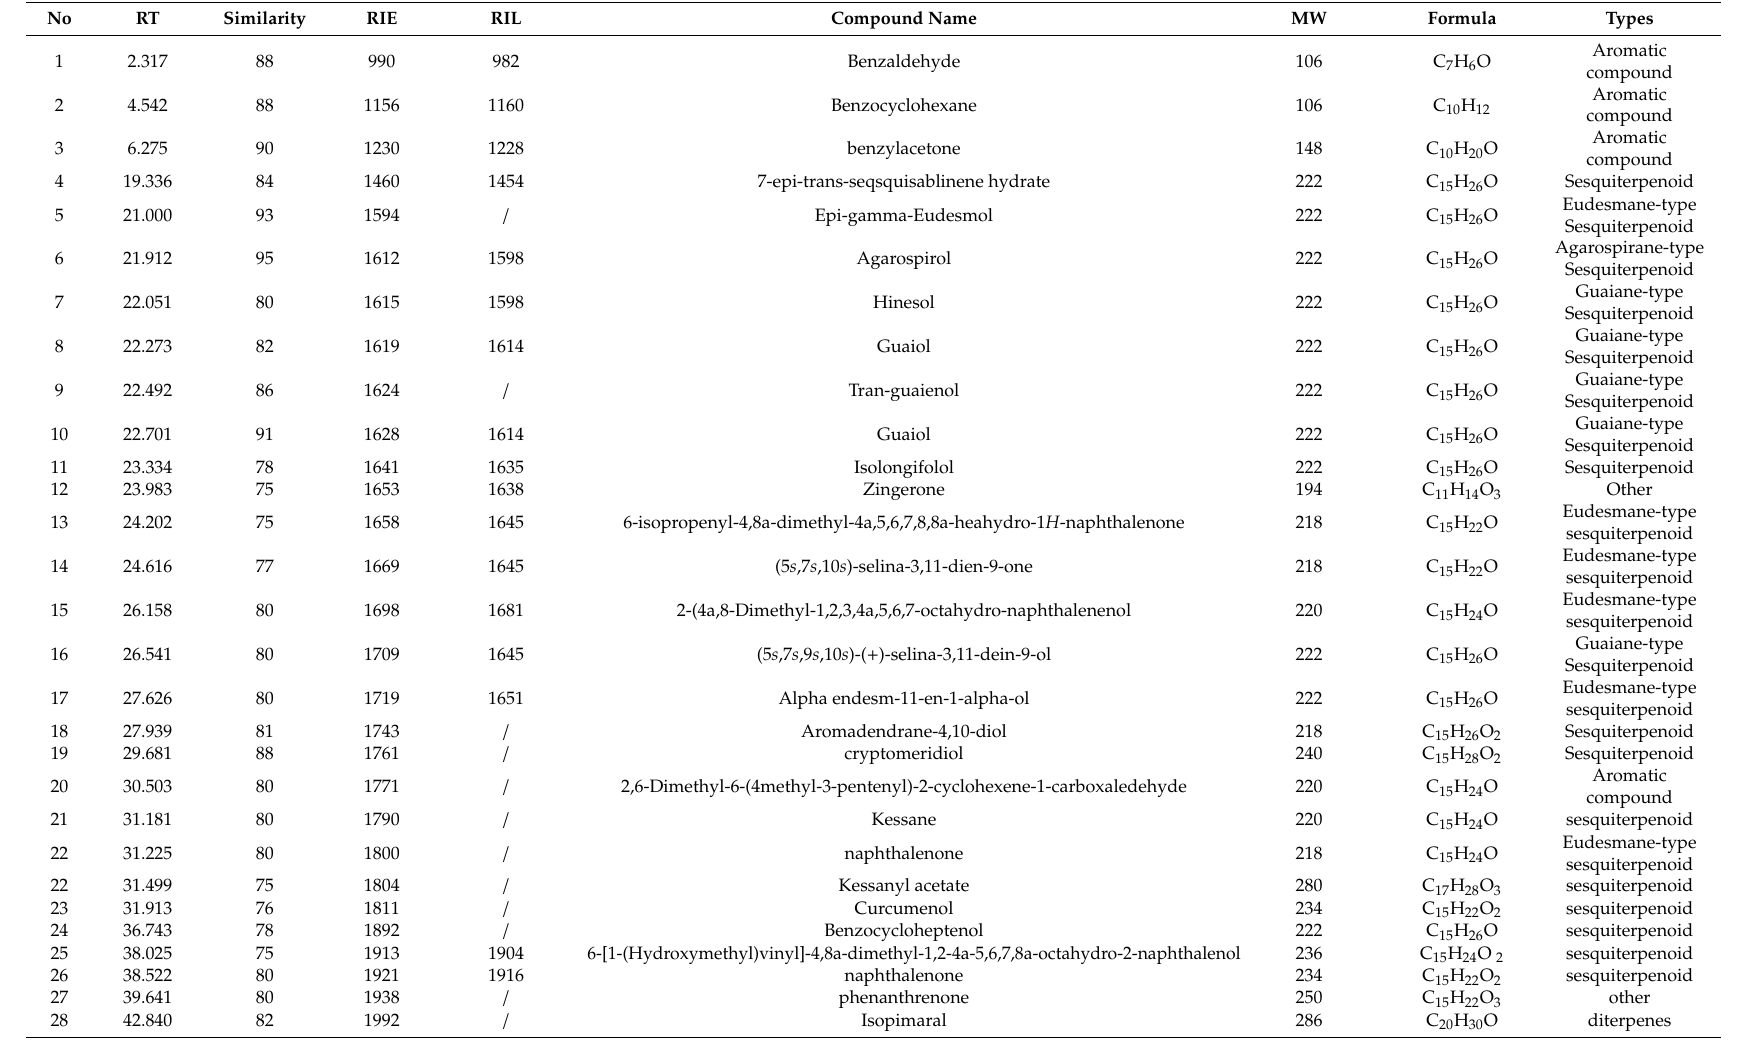
Table 1. Tentative identification of chemical constituents in artificial